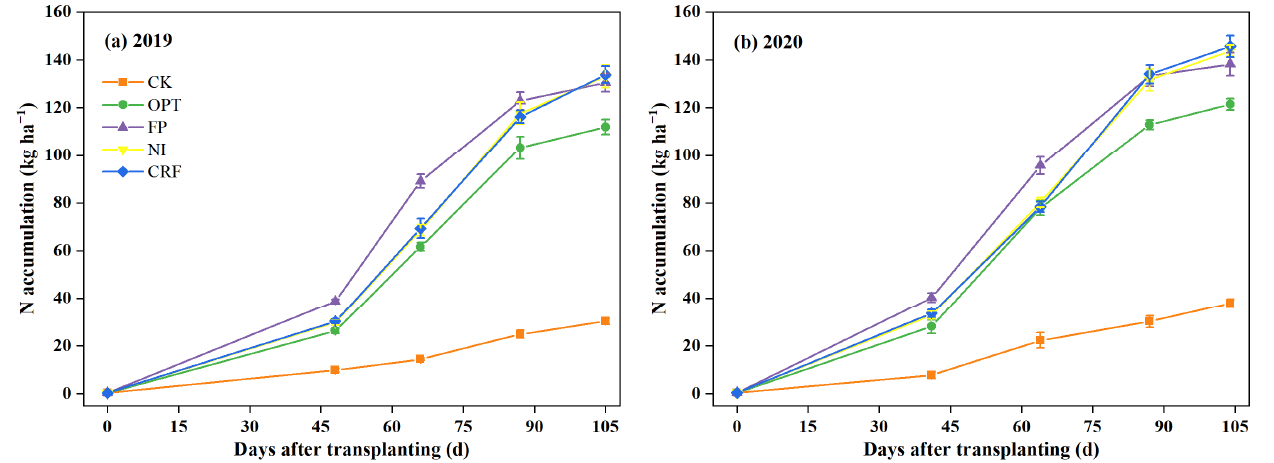
Figure 5. Dynamics of pepper N accumulation under different N management strategies at different growth periods of pepper in 2019 ( a ) and 2020 ( b ). The vertical bars represent the standard error ( n = 4).